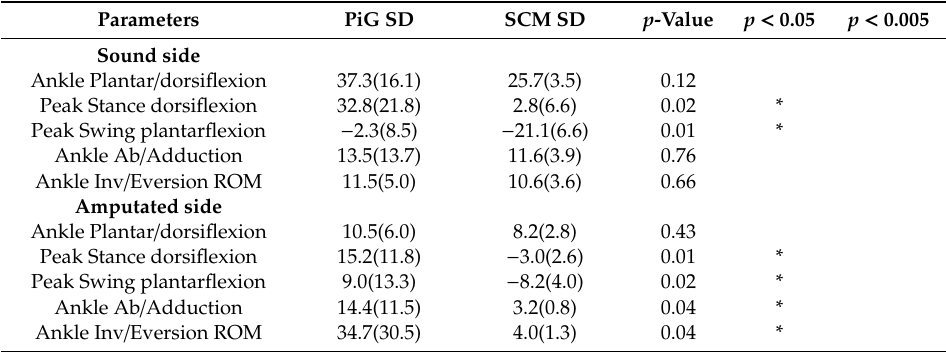
Table 9. Ankle joint angle parameters of seven amputee participants on sound and amputated side as mean SD over three gait cycles calculated by the PiG and SCM.